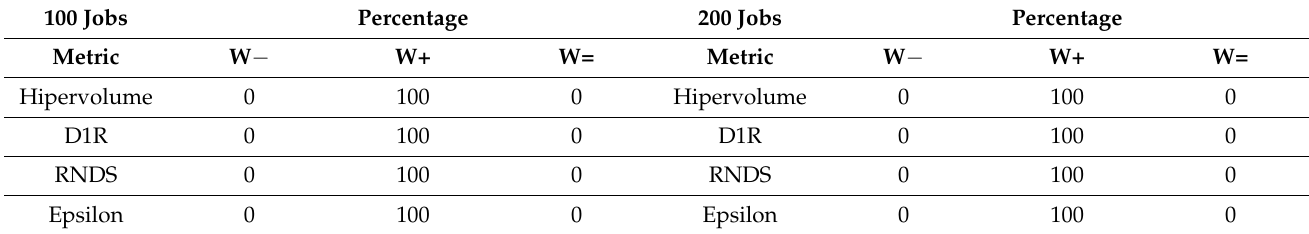
Table 3. Wilcoxon test results on metaheuristics for problems with 100 and 200 jobs.